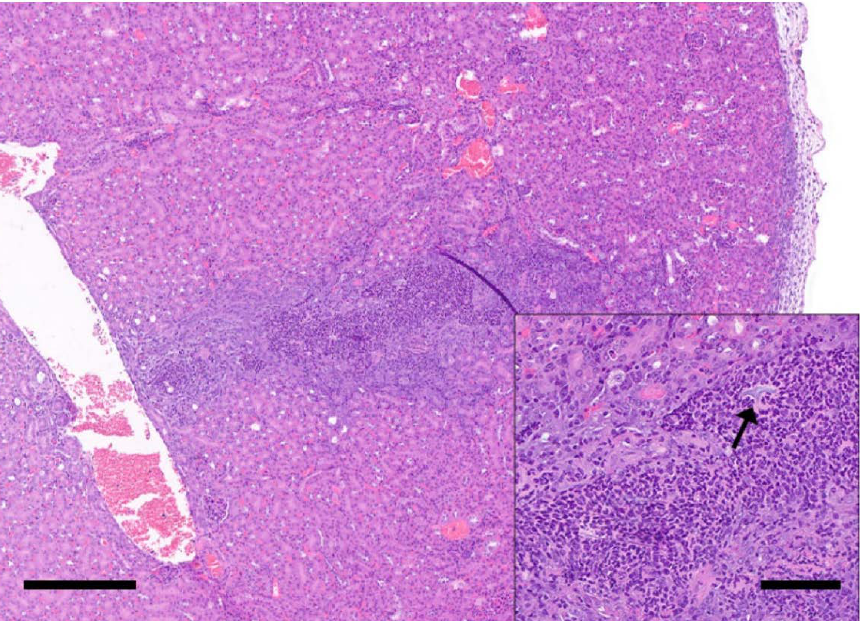
Figure 8. Renal puncture associated with IP injections. Photomicrograph of the caudal pole of the kidney of a mouse receiving repeated IP injections. The renal parenchyma is regionally distorted by a linear tract of neutrophilic inflammatory cell infiltrates with occasional intralesional foreign material (black arrow, inset). The tubules adjacent to the linear tract exhibit marked regenerative changes (i.e., tubular basophilia) and the overlying renal capsule is thickened by inflammatory cells and connective tissue. H&E stain. Left scale bar, 300 µ m; Inset scale bar, 100 µ